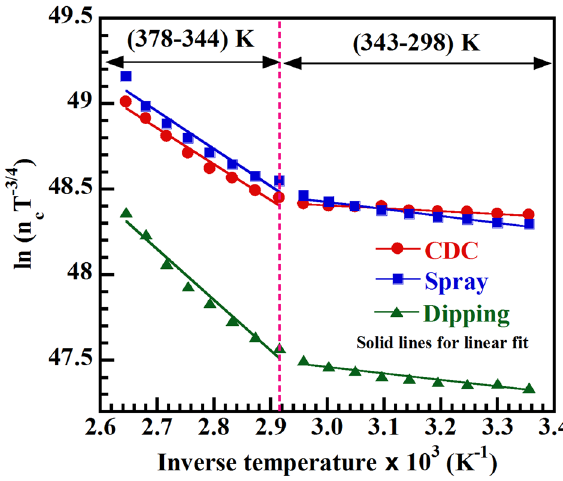
Figure 3. Diagram for calculating acceptor ionization energy. ln(n c T −3/4 ) vs inverse temperature graph for CDC, spray and dipping deposited CH 3 NH 3 PbI 3−x Cl x thin